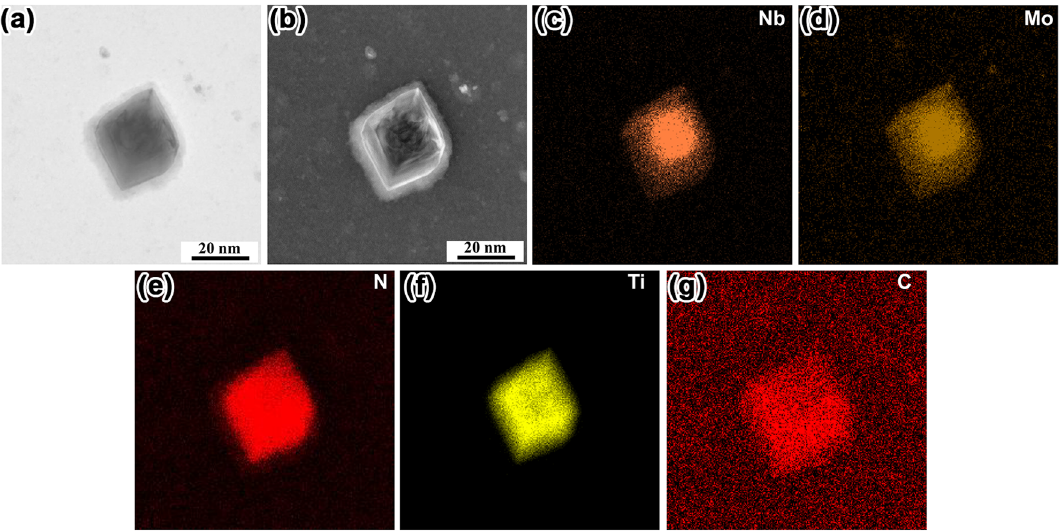
Figure 14. ( a ) STEM BF image of the typical precipitate, ( b ) STEM DF image of the typical precipitate, ( c – g ) EDS mapping of the precipitate in the N4 steel with 0.07% Mo addition.